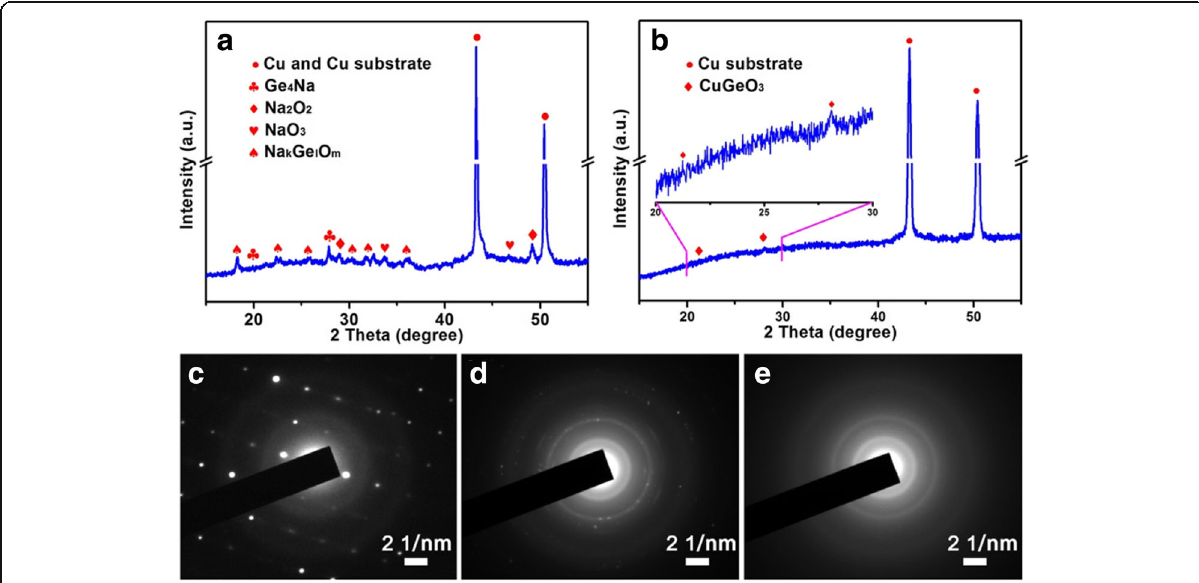
Fig. 4 Ex situ XRD patterns of the CGO electrode when a discharged to 0.05 V and b charged to 2.0 V. c SAED pattern of the CGO samples. SAED patterns of the CGO electrode when d discharged to 0.05 V and e charged to 2.0